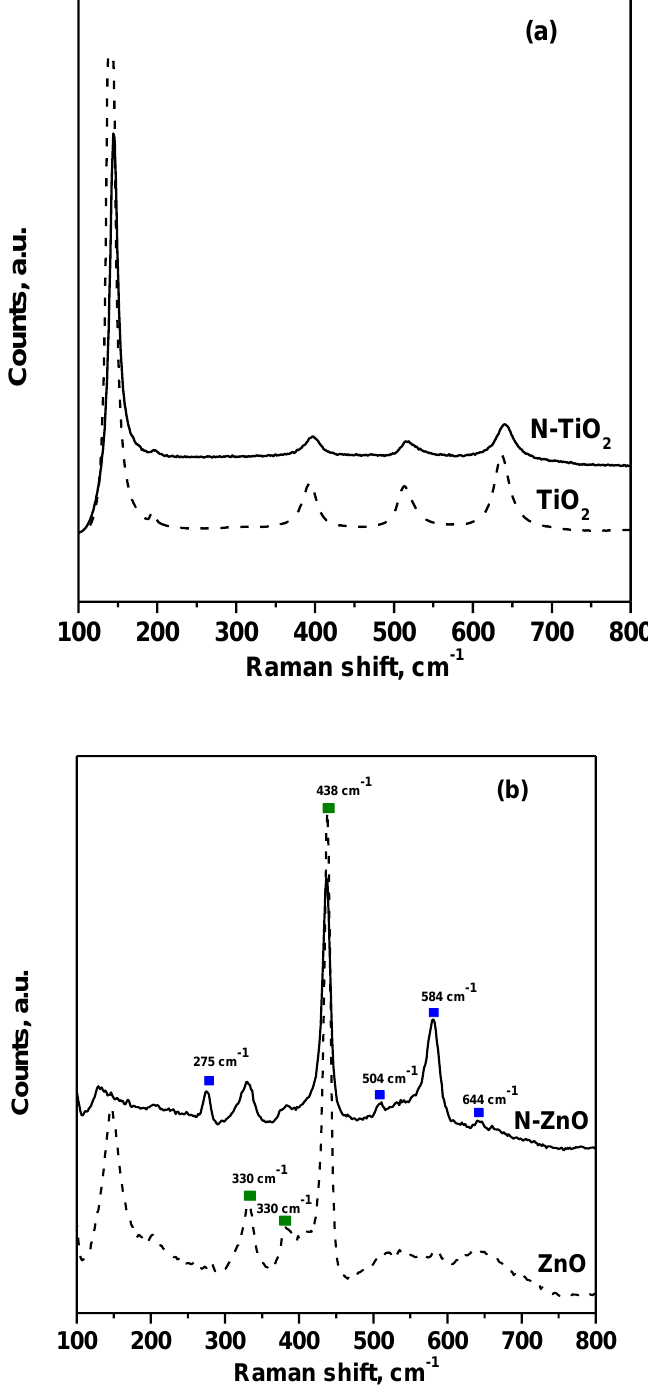
Figure 3. Raman spectra for ( a ) TiO 2 and N-TiO 2 , as well as ( b ) ZnO and N-ZnO samples.